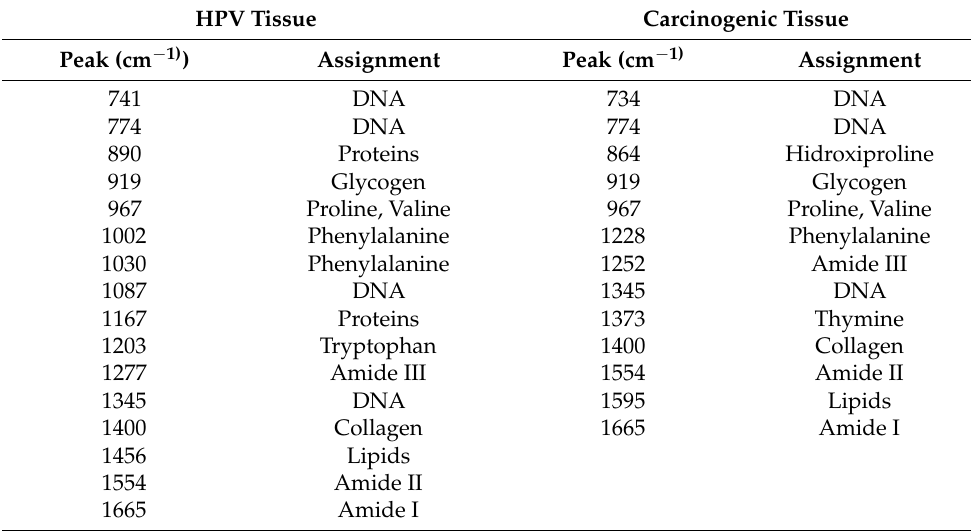
Figure 4. SERS spectra of cervical tissues. Top panel , tissue infected with HPV and marked with Au NPs; bottom panel , tissues with carcinoma, one marked with Au NPs the other without NPs. Table 1. Peaks assignments for SERS spectra of HPV and carcinogenic tissues with Au NPs.